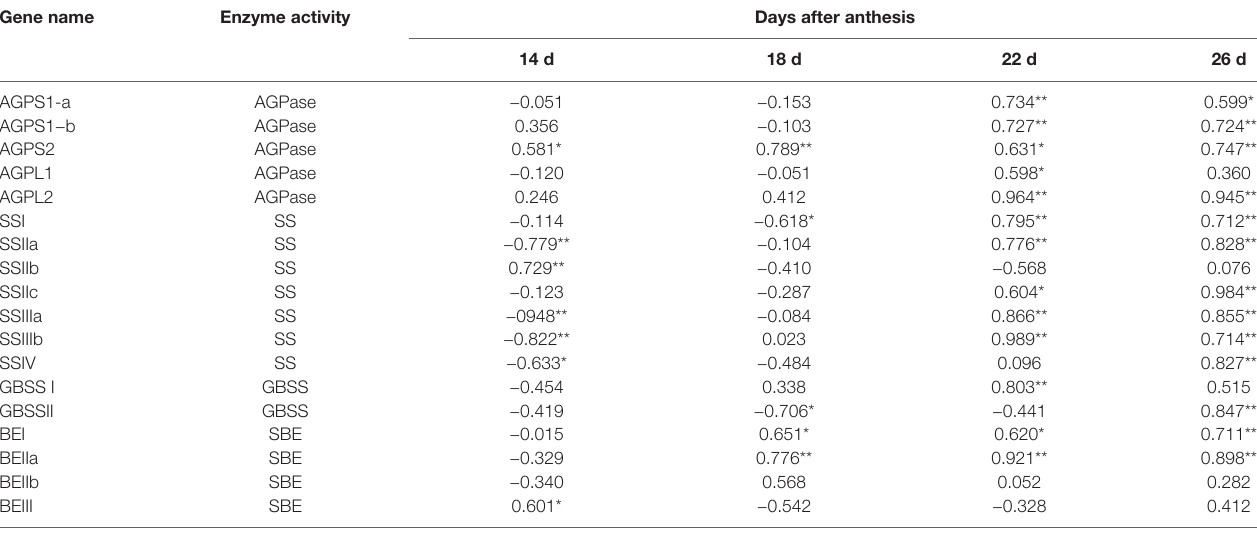
TABlE 3 | Correlation analysis between the activities of key enzymes related to starch biosynthesis and the relative expression of the genes that encode